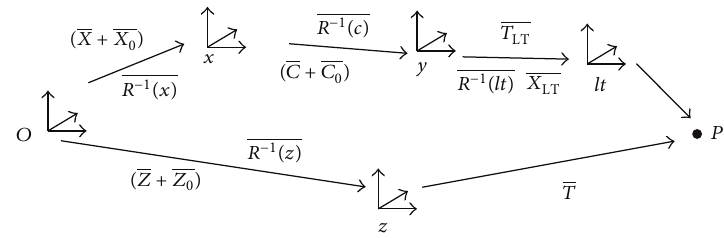
Figure 6: Kinematic scheme of the studied machine